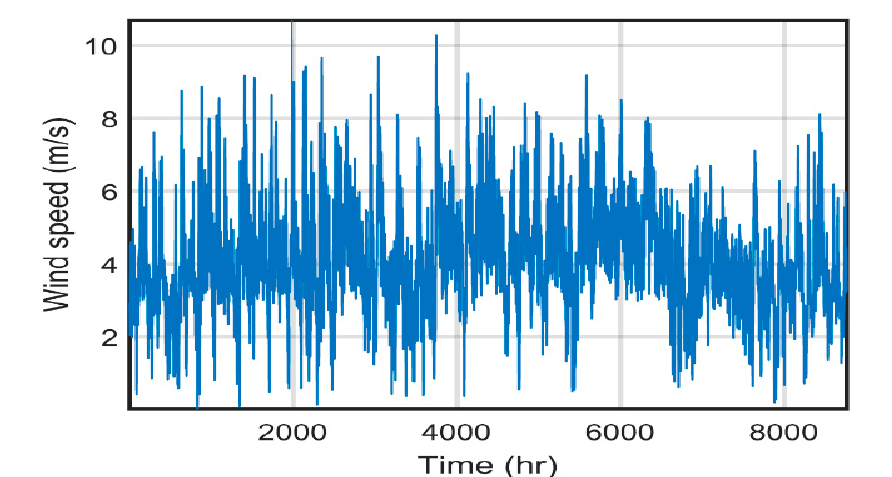
Figure 9. Atmospheric pressure variation in Aswan.